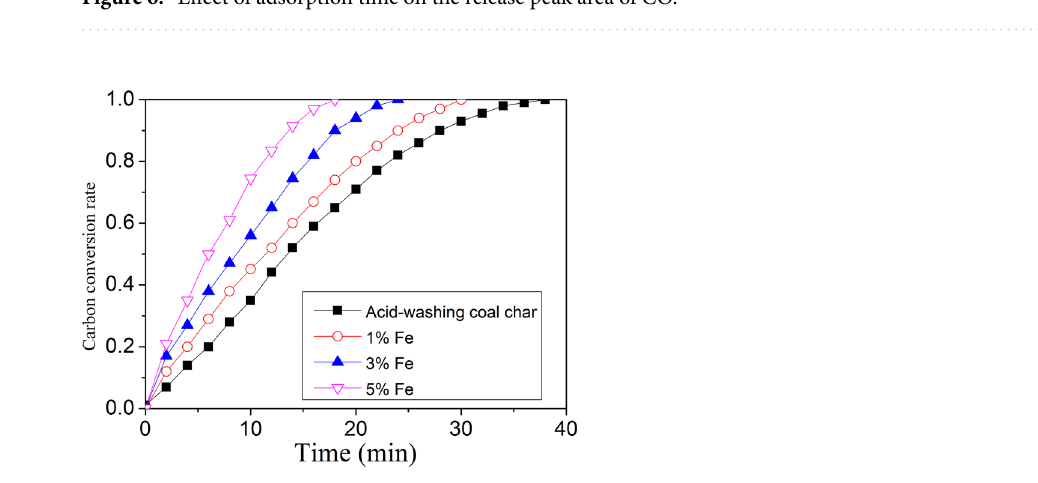
Figure 7. Effect of iron loading on coal char gasification